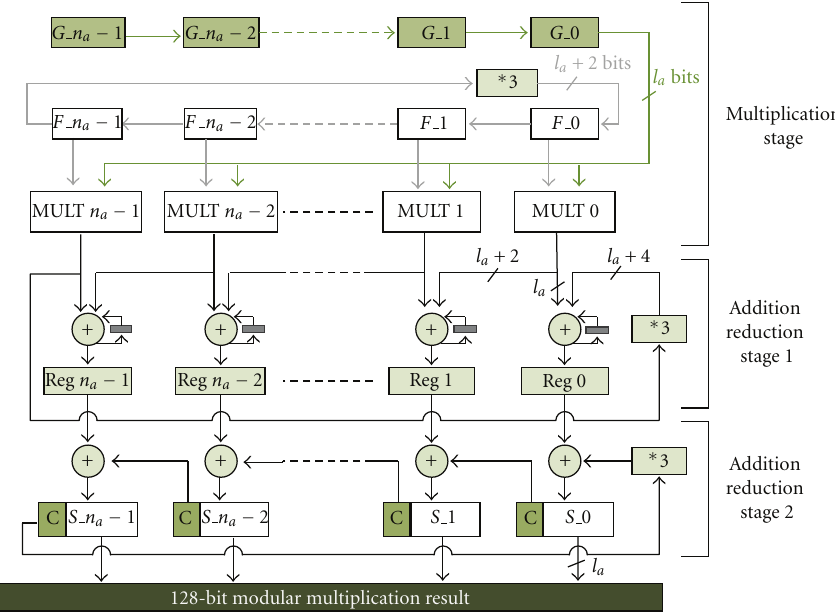
Figure 2: Modular multiplication